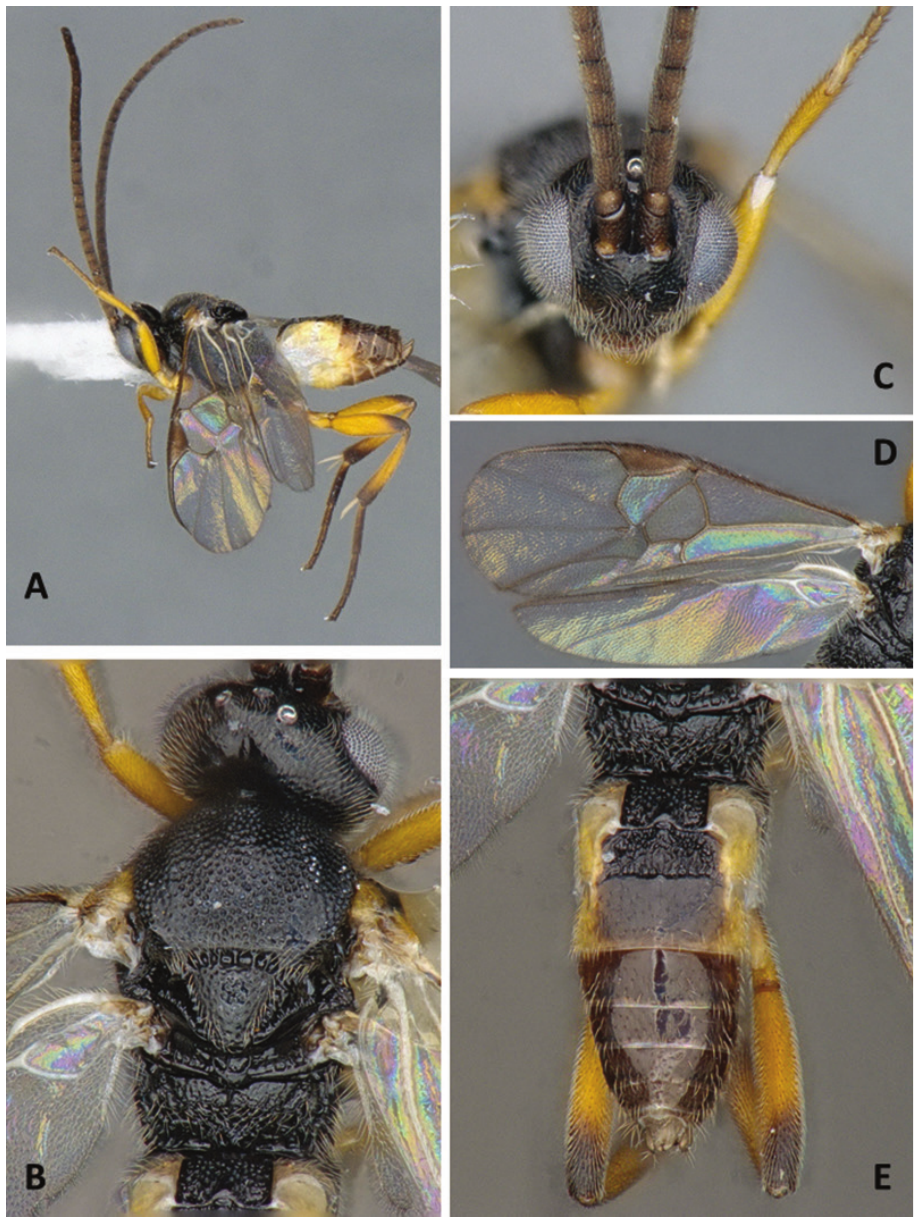
Figure 2. Cotesia icipe , male paratype. A Habitus lateral B Head and mesosoma dorsal C Head frontal D Wings E Propodeum and metasoma